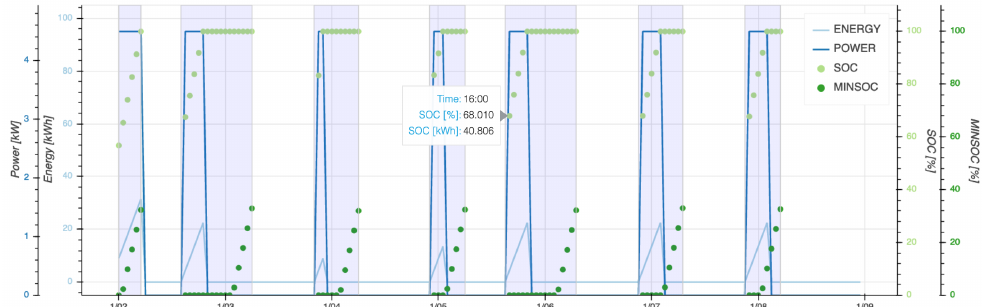
Figure 7. Plot of a single consumer’s simulated week of charge/discharge cycles. The blue and light-blue curves represent the power and energy supplied to the EV by the grid for each time sample. The dotted curves represent the SOC and MINSOC (i.e., minimum amount of energy to be charged in the EV)values of the EV for each time sample. The light-blue frames represent the time epochs in which the EV is actually connected to the